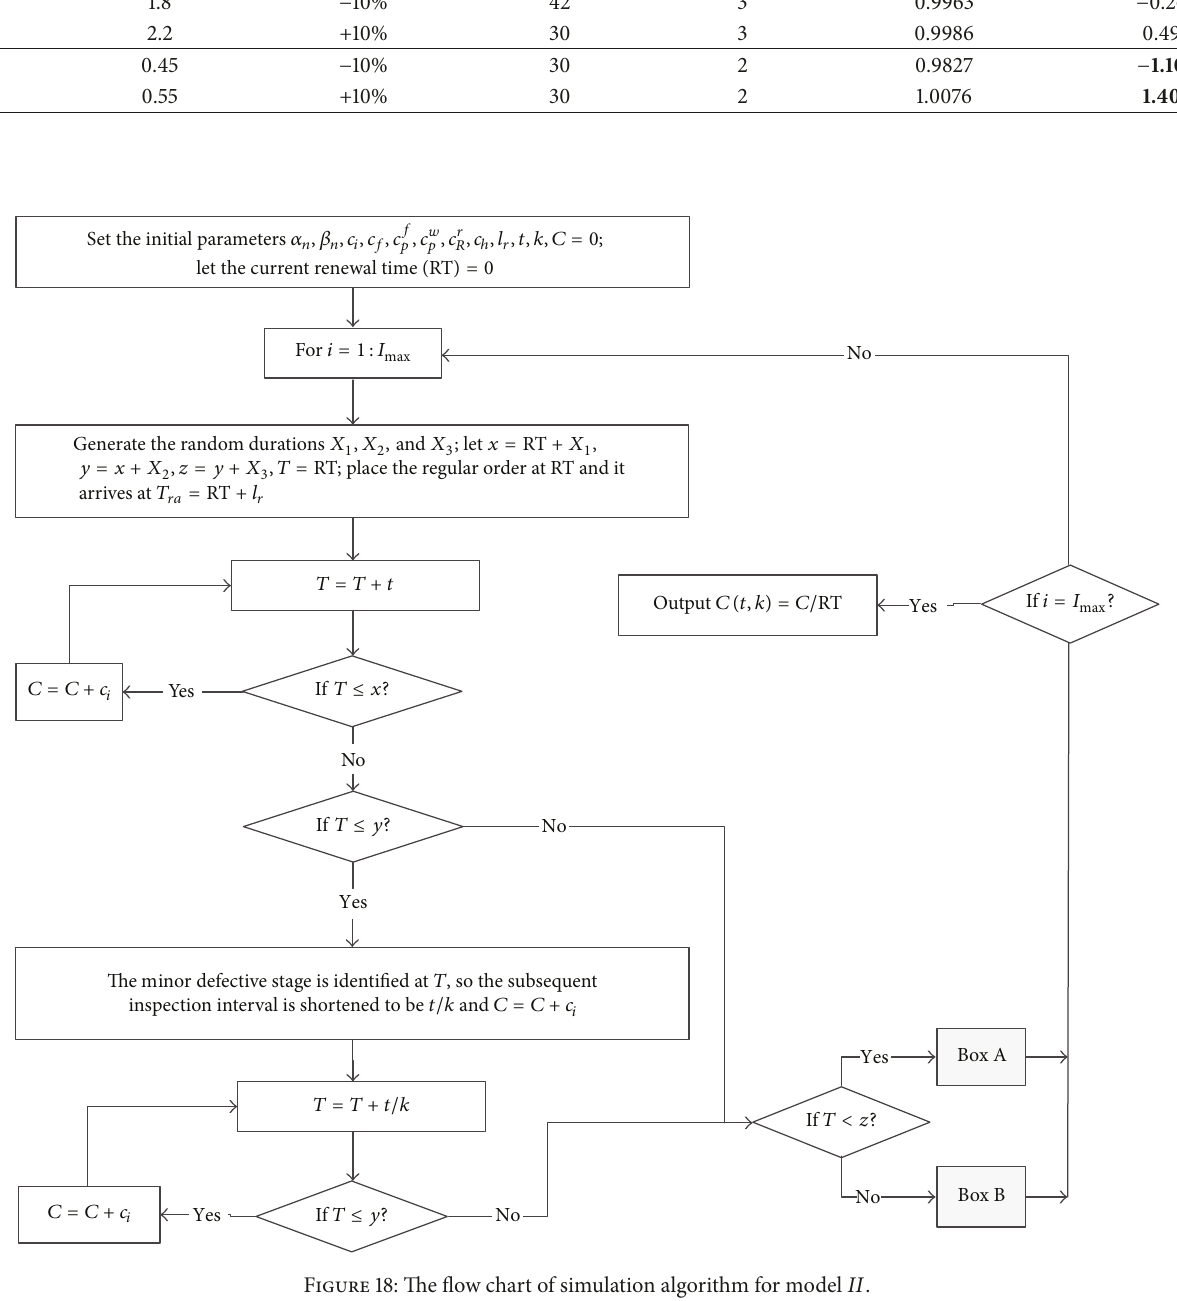
Figure 18: The flow chart of simulation algorithm for model 𝐼𝐼